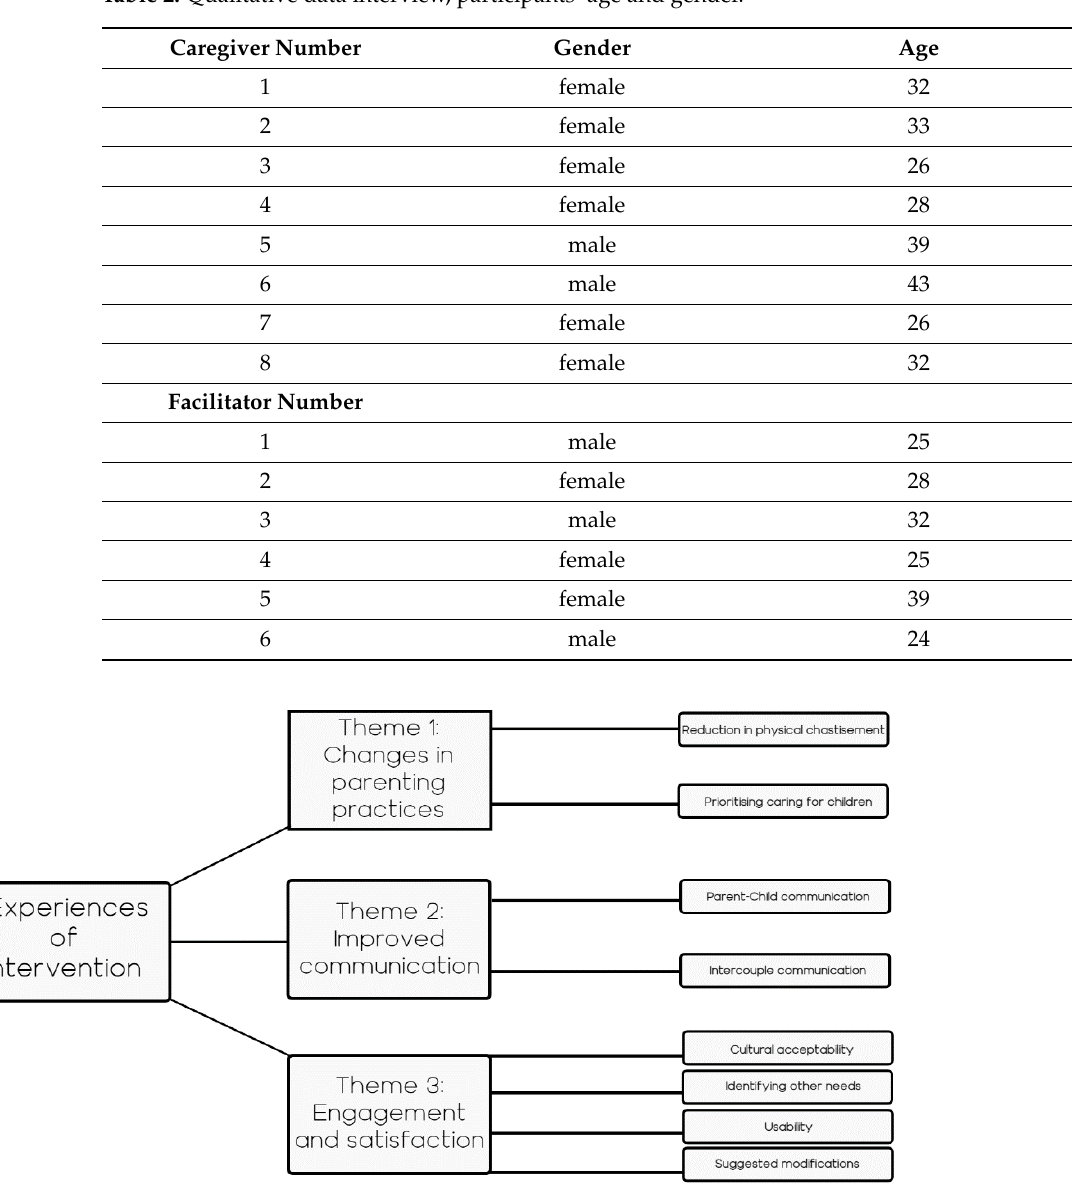
Table 2. Qualitative data interview, participants’ age and gender.